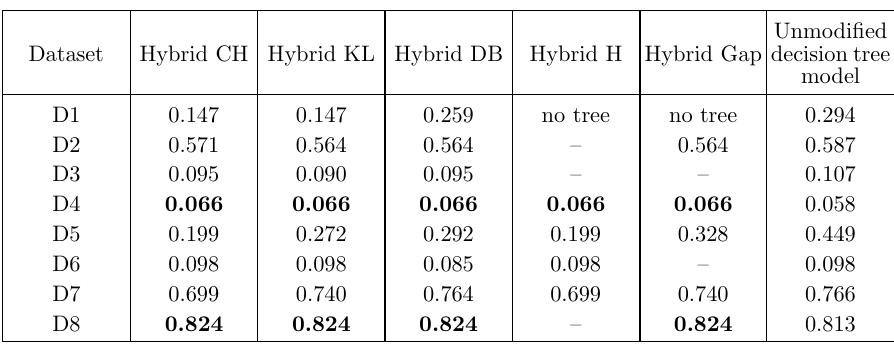
Values of precision